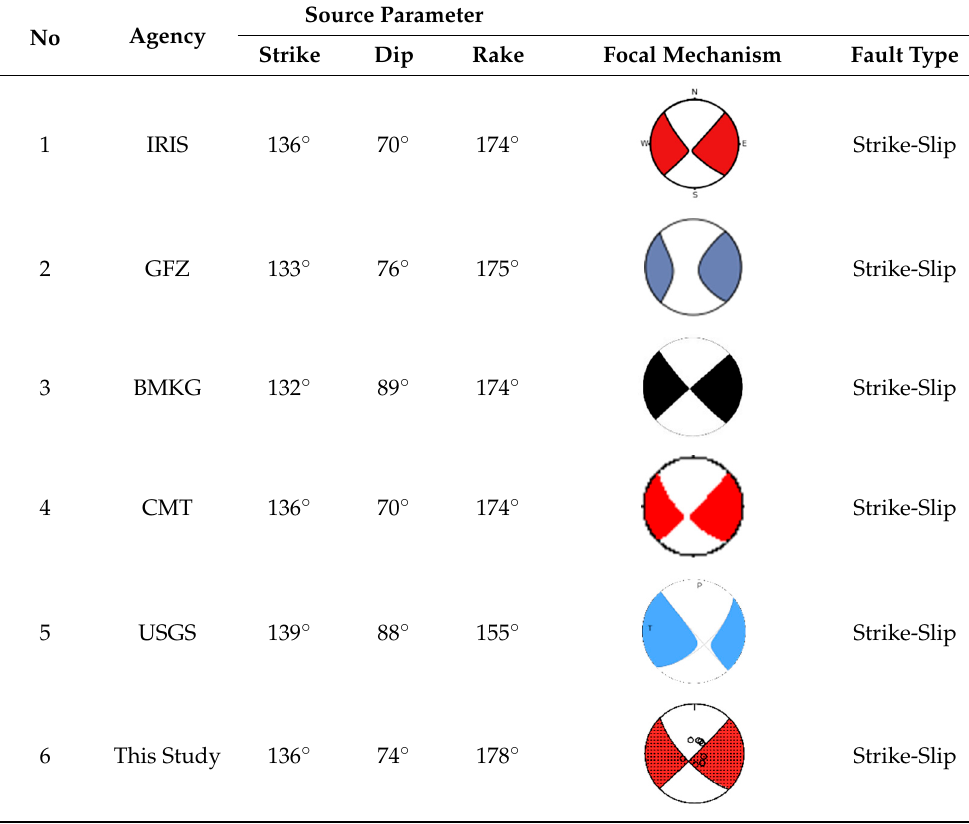
Table 1. Comparison of the focal mechanism outcomes between this work and various agencies.